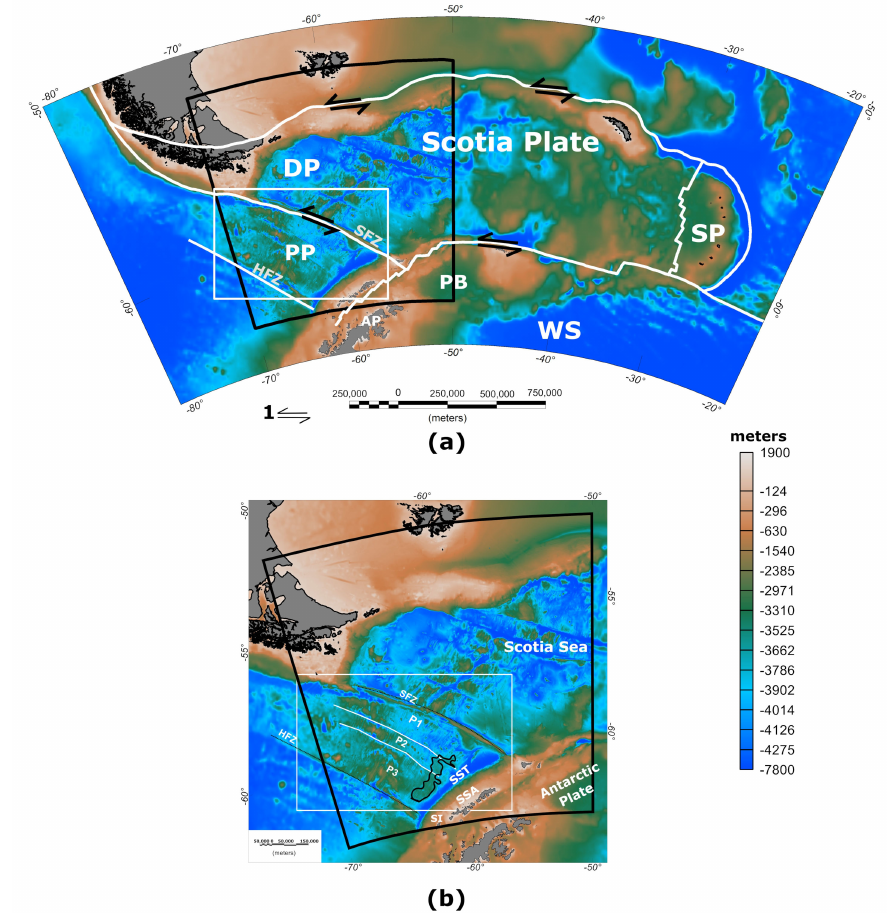
Figure 1. Scotia Sea and study area. ( a ) General bathymetry map of the Scotia Sea. Plate boundaries in thick white curvilinear lines. AP: Antarctic Peninsula. DP: Drake’s Passage. PP: Phoenix Plate. SP: Sandwich Plate. WS: Weddell Sea. PB: Powell Basin. ( b ) P1, P2, and P3 denote the three inactive plate segments of the Phoenix Ridge. SSA: South Shetland archipelago. SST: South Shetland Trench. SI: Smith Island. A black solid irregular polygon highlights the flexural bulge. Two white thin lines separate P1, P2, and P3 zones. In upper or lower figures: A white rectangle highlights the study area. HFZ: Hero Fracture Zone. SFZ: Shackleton Fracture Zone. Both fracture zones are depicted with solid white lines (upper panel) and thin black lines (lower panel). Two sources of topographic/bathymetry data were used here: the SRTM30 Plus v7 [6] for the background image, and the new digital bathymetric model with 200 m spatial resolution [7] for the study area. The later one is delimited by a black solid circular sector. 1: Transcurrent